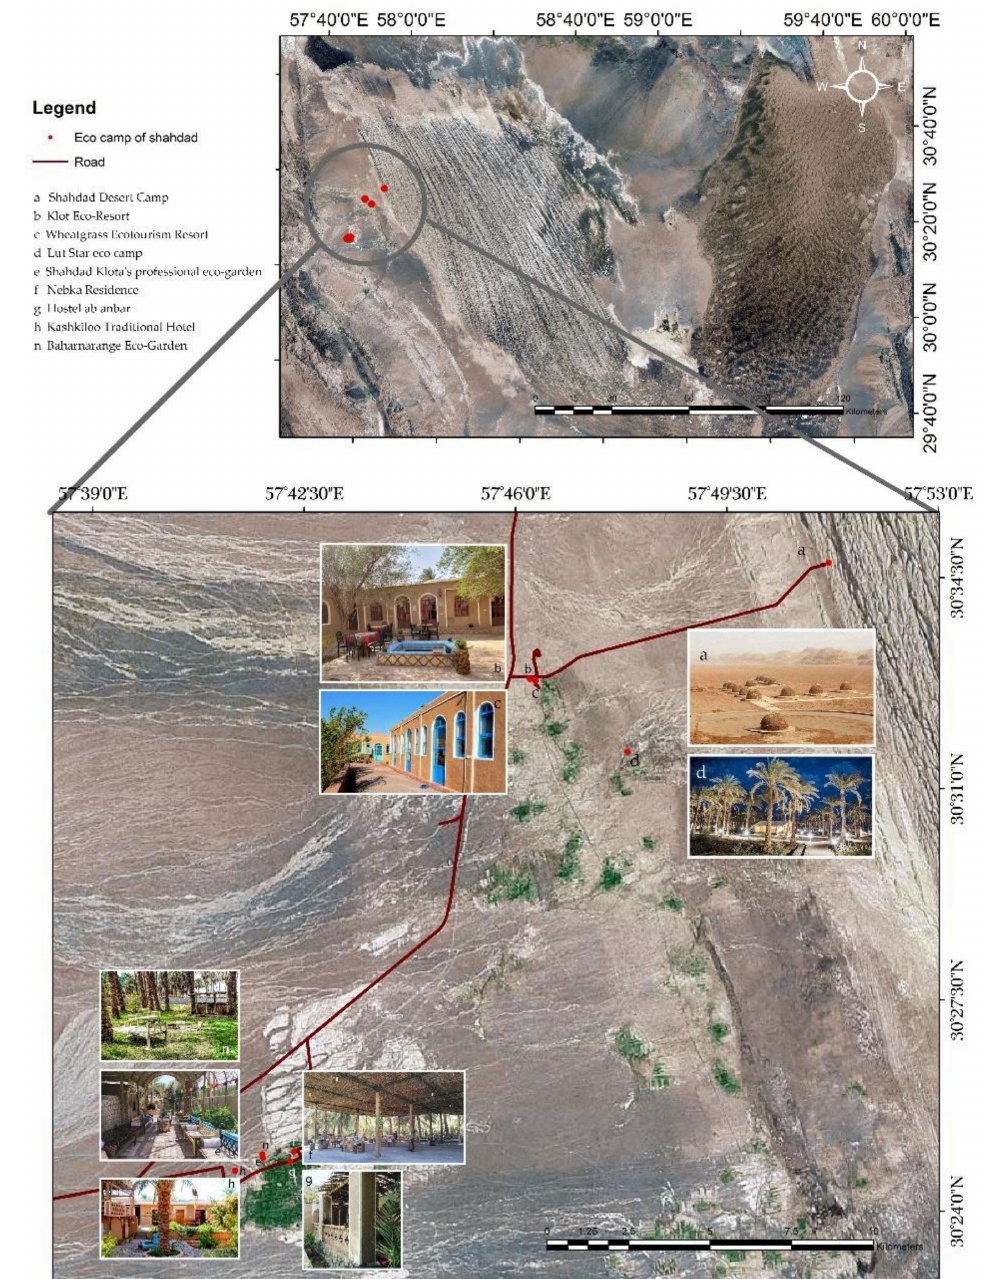
Figure 6. The potential for geotourism is insufficiently exploited through limited visitor recep- tion infrastructure. Eco-camp network and capacities to serve geotourists and ecotourists in the Shahdad